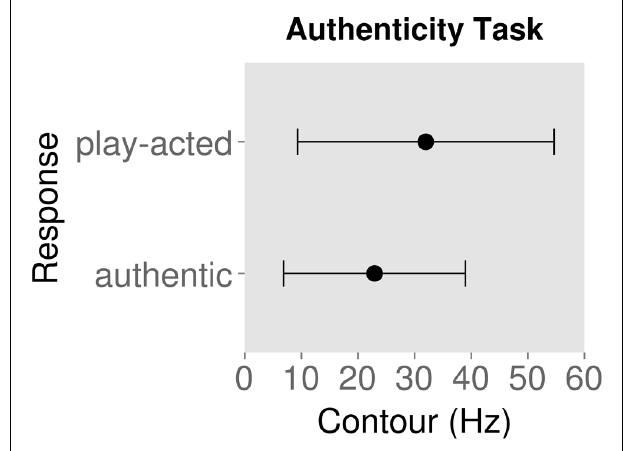
FIGURE 2 | Mean contour (measured as standard deviation of fundamental frequency) and standard deviation for behavioral responses to rating stimuli as authentic or play-acted.